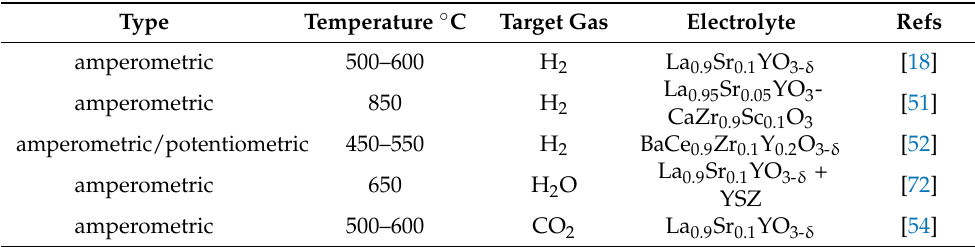
Table 3. Electrochemical gas sensors based on proton-conducting